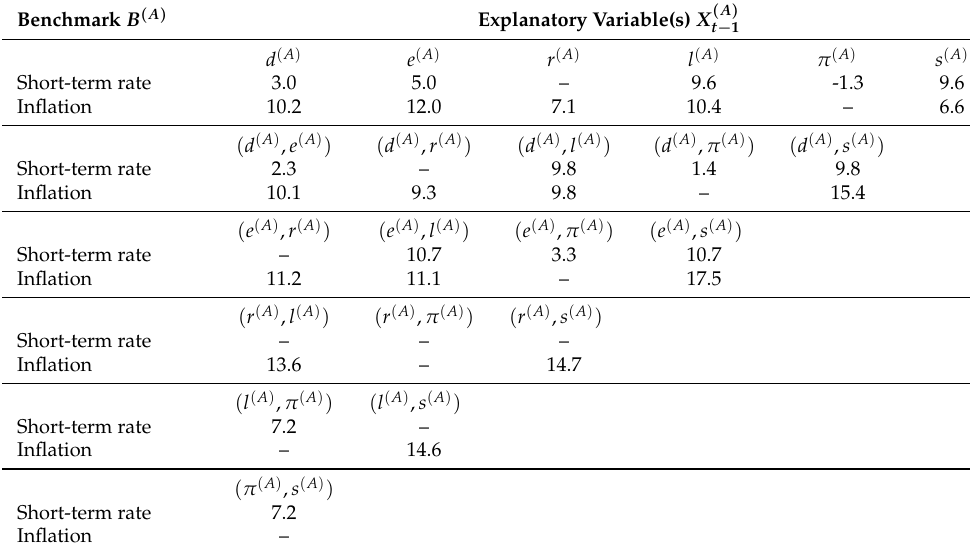
Table 3. Predictive power (%) for the one-year excess stock returns Y prediction problem defined in (2). The predictive power is measured by R 2 The benchmarks B ( A ) considered are based on the short-term interest rate ( A ≡ R ) and the inflation rate ( A ≡ C ). The predictive variables used are X in (4). “–” indicates not applicable cases of matched covariate with benchmark. l ( R ) equals s ( R ) by construction as explained in the footnote in Section